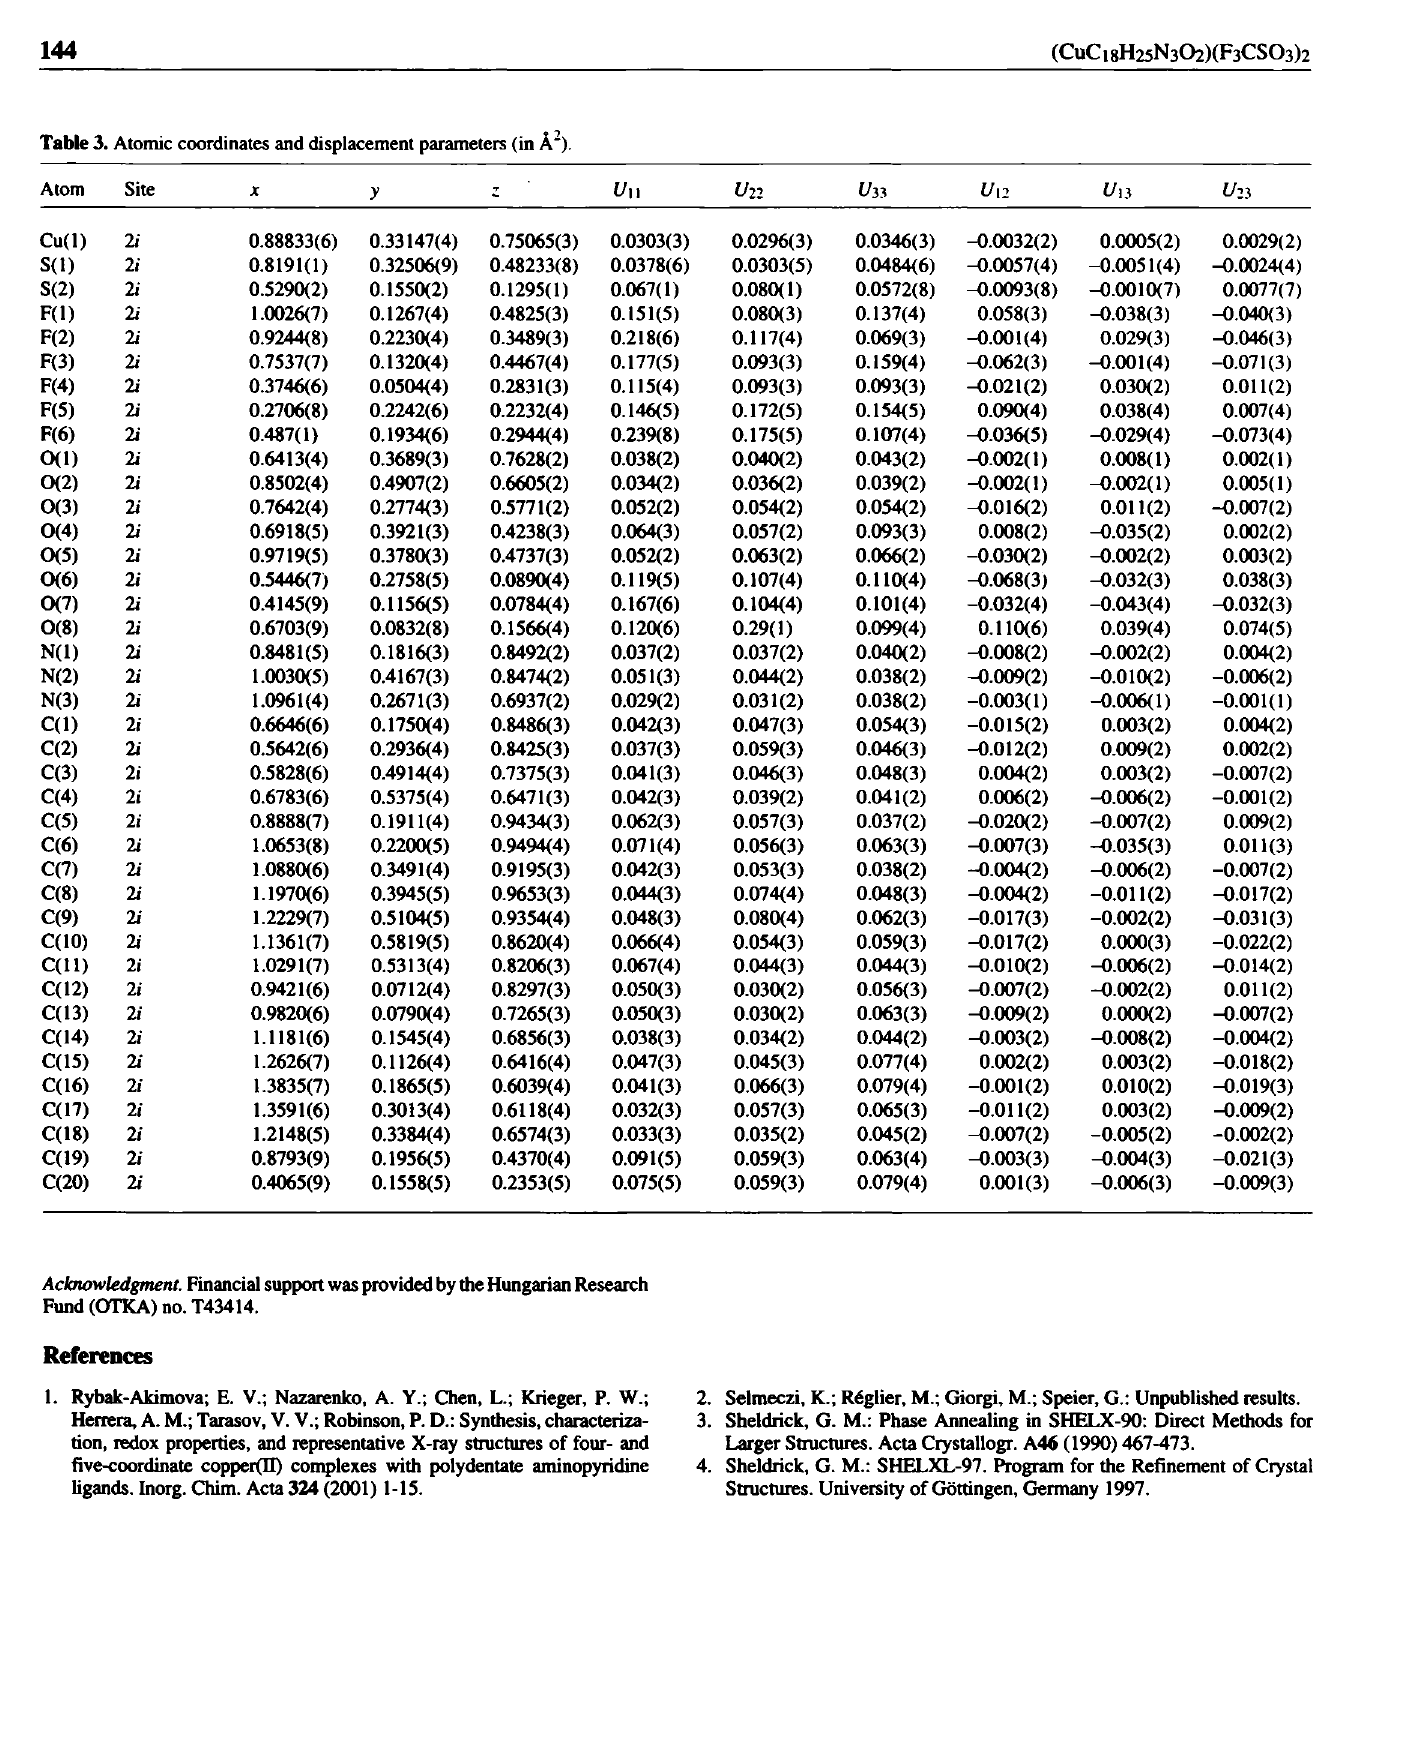
Table 3. Atomic coordinates and displacement parameters (in Â 2